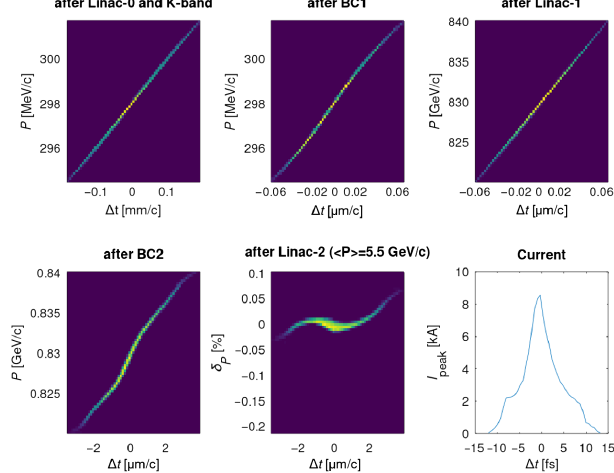
.FIG. 1. The fraction of the action amplification factor exceed- ing 1 under the effects of short-range wakefields in the Ka-band linearizer, as a function of the Ka-band length and of the iris aperture